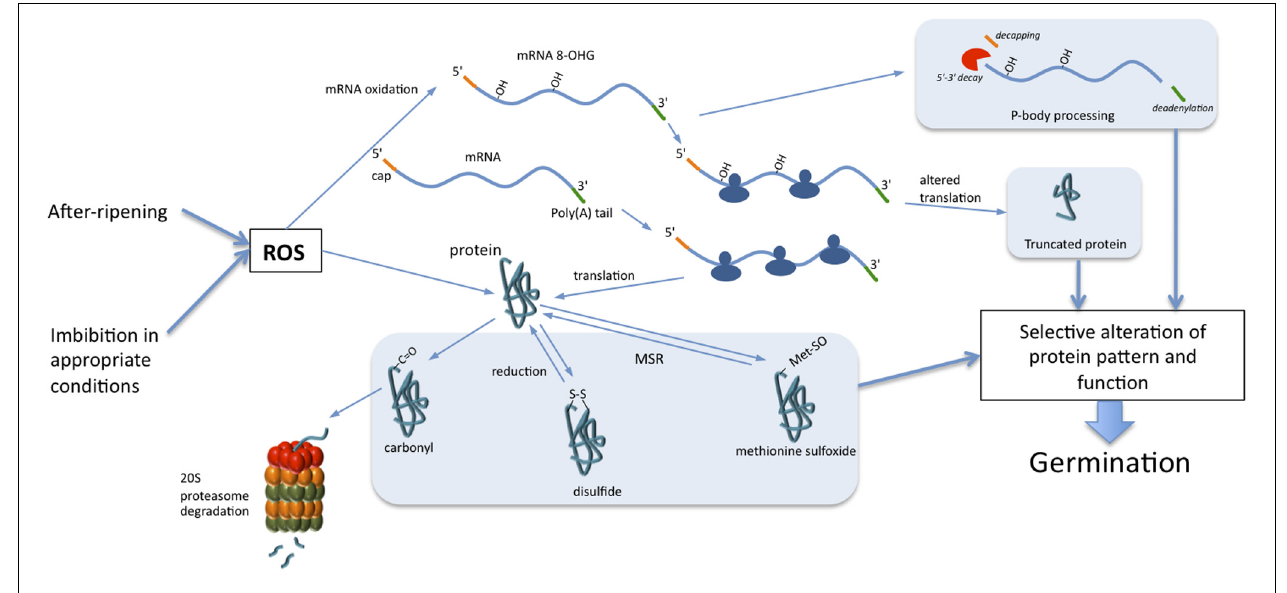
methionine induces formation of disulfide bonds and methionine sulfoxide, respectively. Reduction of disulfide bonds occurs through the action of thioredoxins, peroxiredoxins, or glutaredoxins when methionine sulfoxides are reduced to methionine by methionine sulfoxide reductase (MSR).The selective oxidation of a subset of mRNAs and proteins guides cell signaling pathways toward the completion of seed